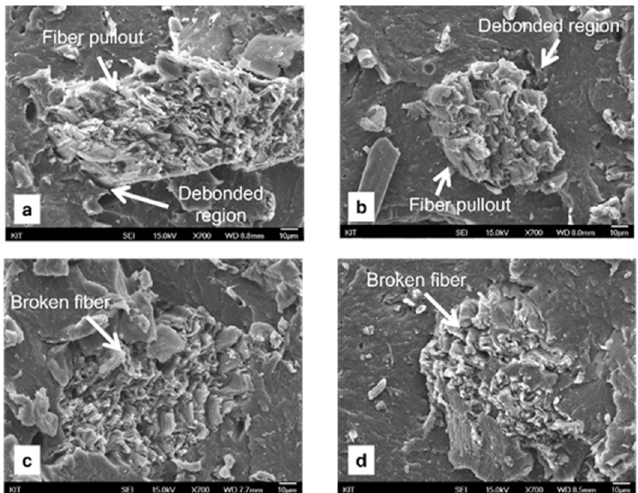
Figure 12. SEM images (×700) of the fracture surfaces of ( a , b ) untreated and ( c , d ) alkali-treated hen- equen fiber/PA6 composites produced via ( a , c ) hopper feeding and ( b , d ) side